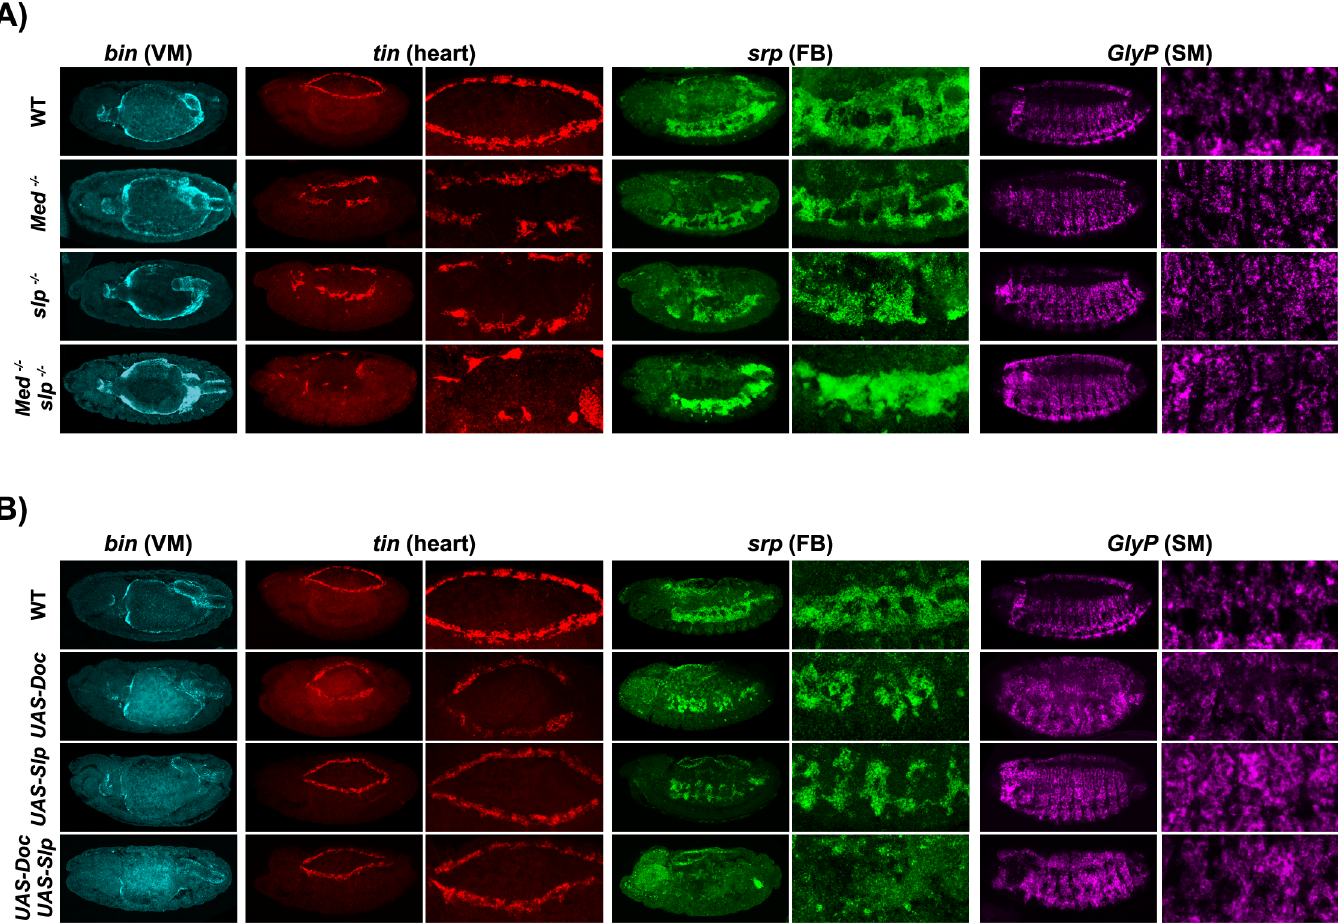
Fig 6. In situ RNA staining for two sets of single and double mutants. A: Slp lof and Med lof each results in a perturbation of H. The double mutant displays an even stronger disruption of H, along with a clear expansion of Srp expression. These experimental results are largely consistent with our model predictions and further provide interpretational clues regarding mixed expression patterns. B: Slp gof exhibits a loss of VM, while FB appears perturbed in both Doc gof and Slp gof mutants. The combination of these perturbations leads to stronger losses of FB and VM, while H and SM are barely affected. These results qualitatively agree with model